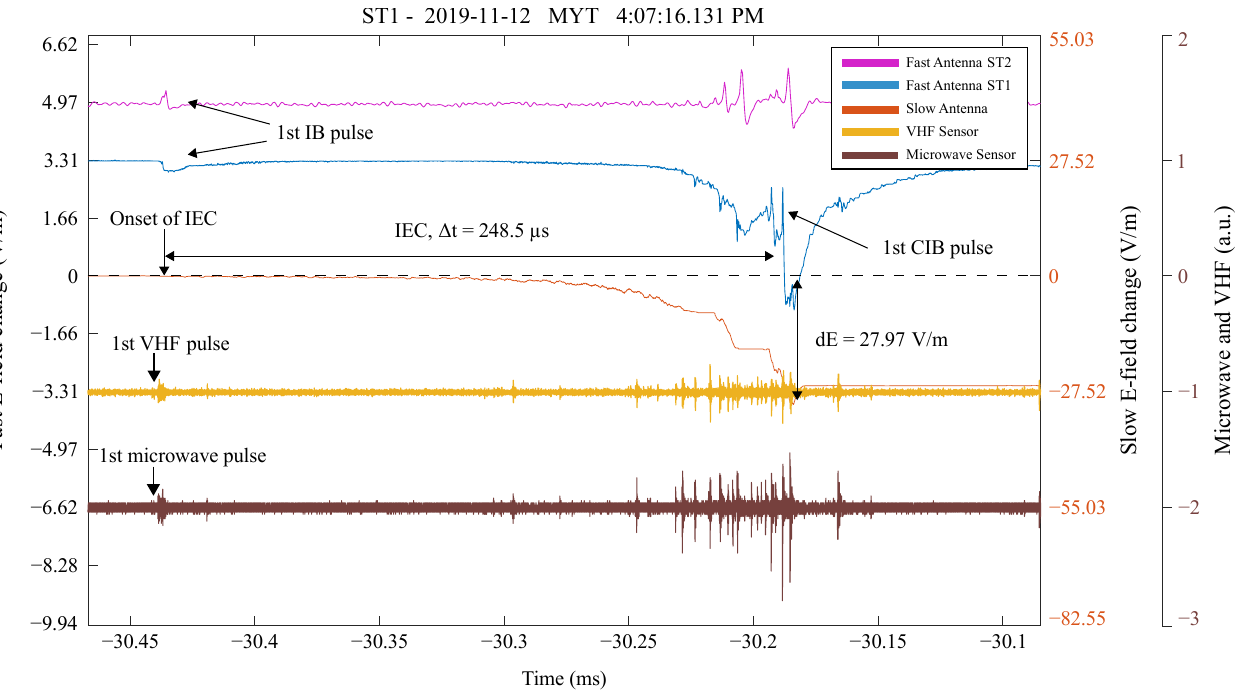
Figure 3. An example of a -CG flash within reversal distance at ST1 (CG-4: Atmospheric sign convention) with detection of IECs, microwave, and VHF pulses detected on 12 November 2019 at 4:07:16:131 PM MYT. [Sampling rate: 2.5 GS/s for microwave, 250 MS/s for FA, SA, and VHF].